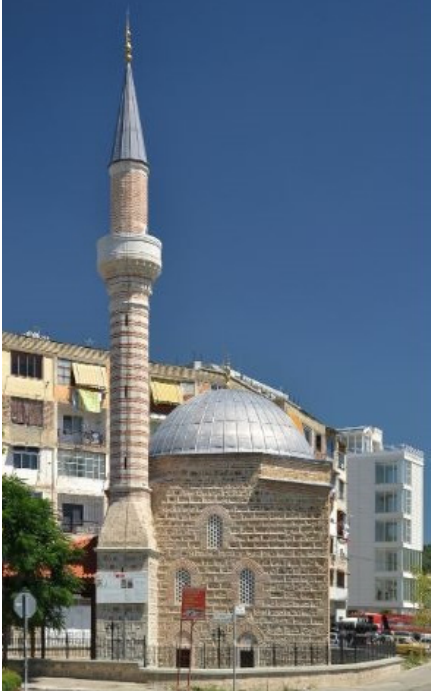
Figure 4. Views of the Naziresha Mosque after the restoration works [9].